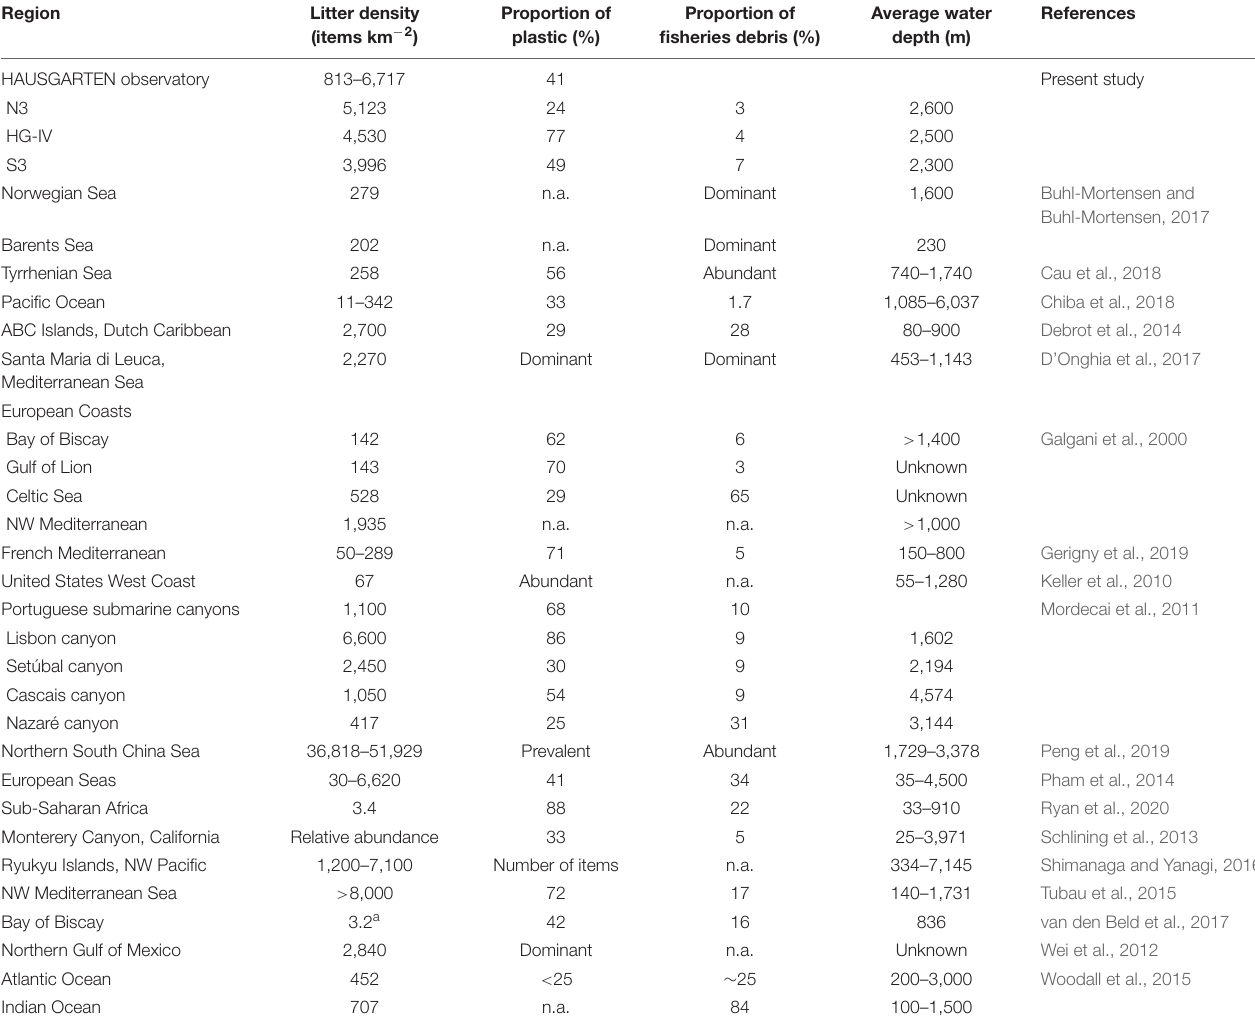
TABLE 6 | Litter densities and plastic proportion of studies from the deep seafloor worldwide. Region Litter density